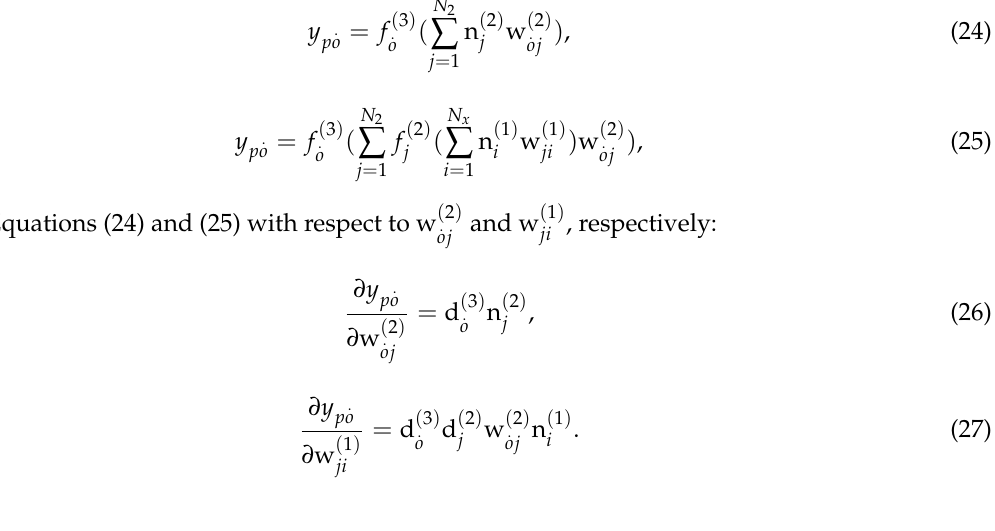
Figure 3. Pseudocode for Jacobian matrix.